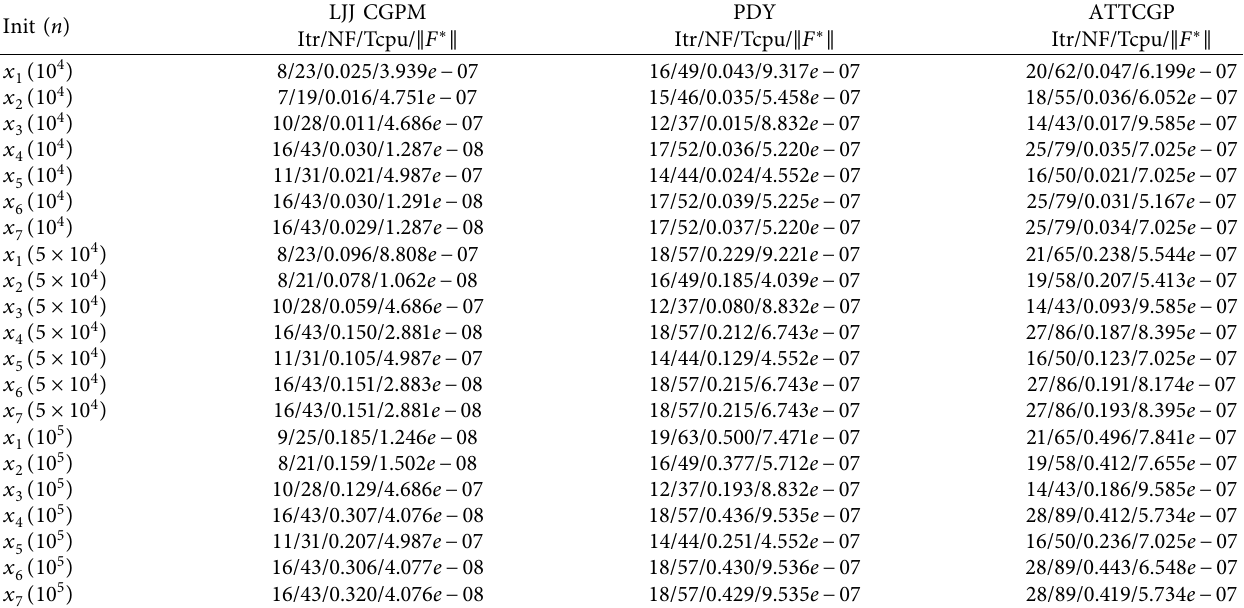
Table 1: Numerical results on Problem 1.